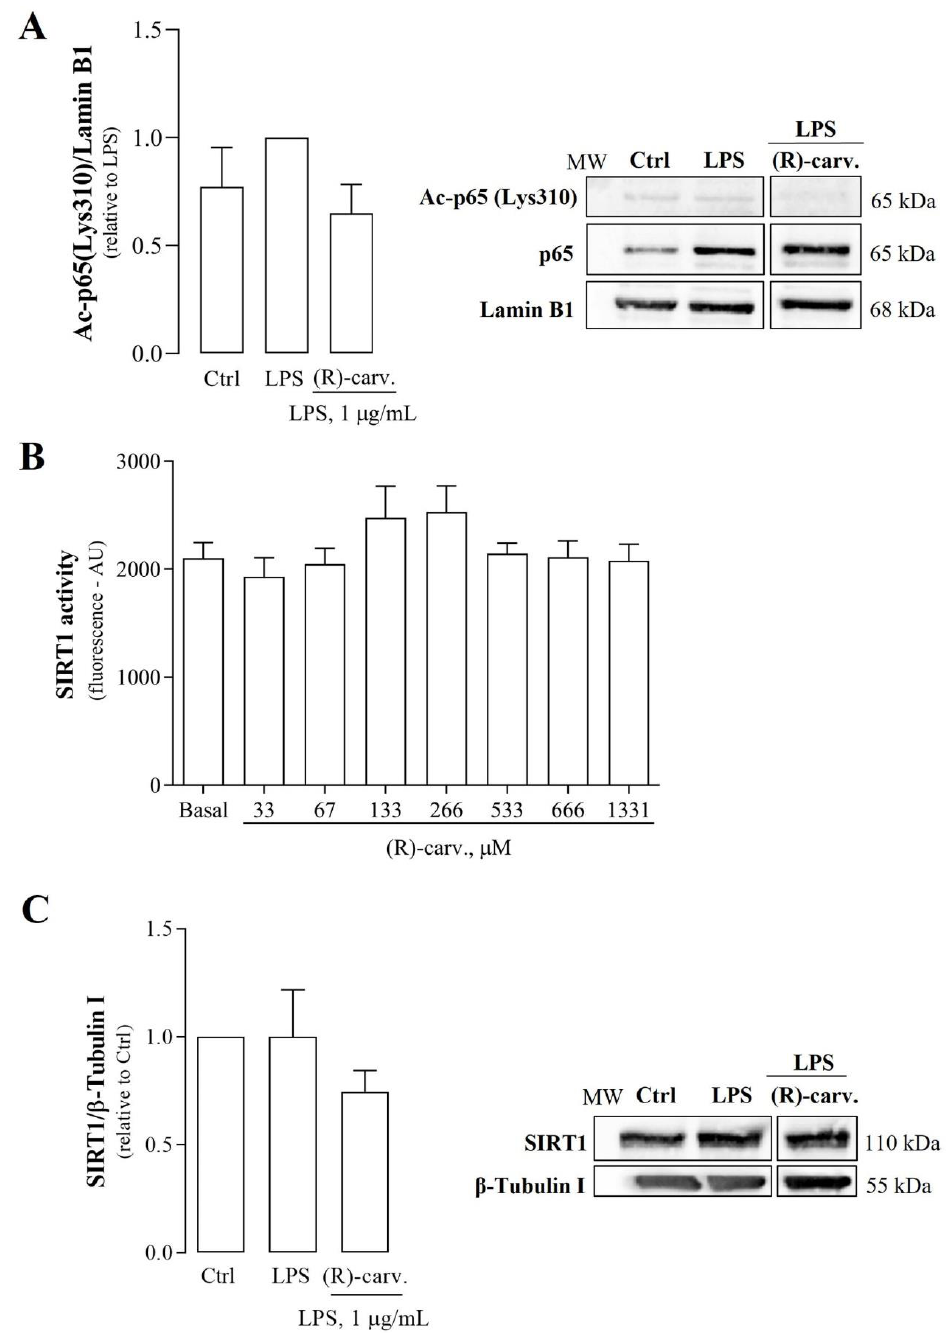
Figure 6. Effect of (R)-(-)-carvone on acetylated Lys310 NF- κ B/p65 (Ac-p65) levels ( A ), SIRT1 activity ( B ) and protein levels ( C ). In ( A , C ), macrophages were pre-treated with the vehicle (0.1% DMSO) or 665 µM (R)-(-)-carvone for 1 h, followed by treatment with 1µg/mL LPS for 1 h. Control cells (Ctrl) were treated with the vehicle (0.1% DMSO) alone. ( B ) Different concentrations of (R)-(-)-carvone were directly incubated with human recombinant SIRT1 and a specific substrate, as described in Materials and Methods. Each column represents the mean ± SEM of three( A ), at least six, ( B ) and three ( C ) independent experiments. Supplementary Table S2 shows the raw data of the results presented in panel A. Representative images are shown. The corresponding images of the full-length blots are shown in Supplementary Figure S1. MW: molecular weight